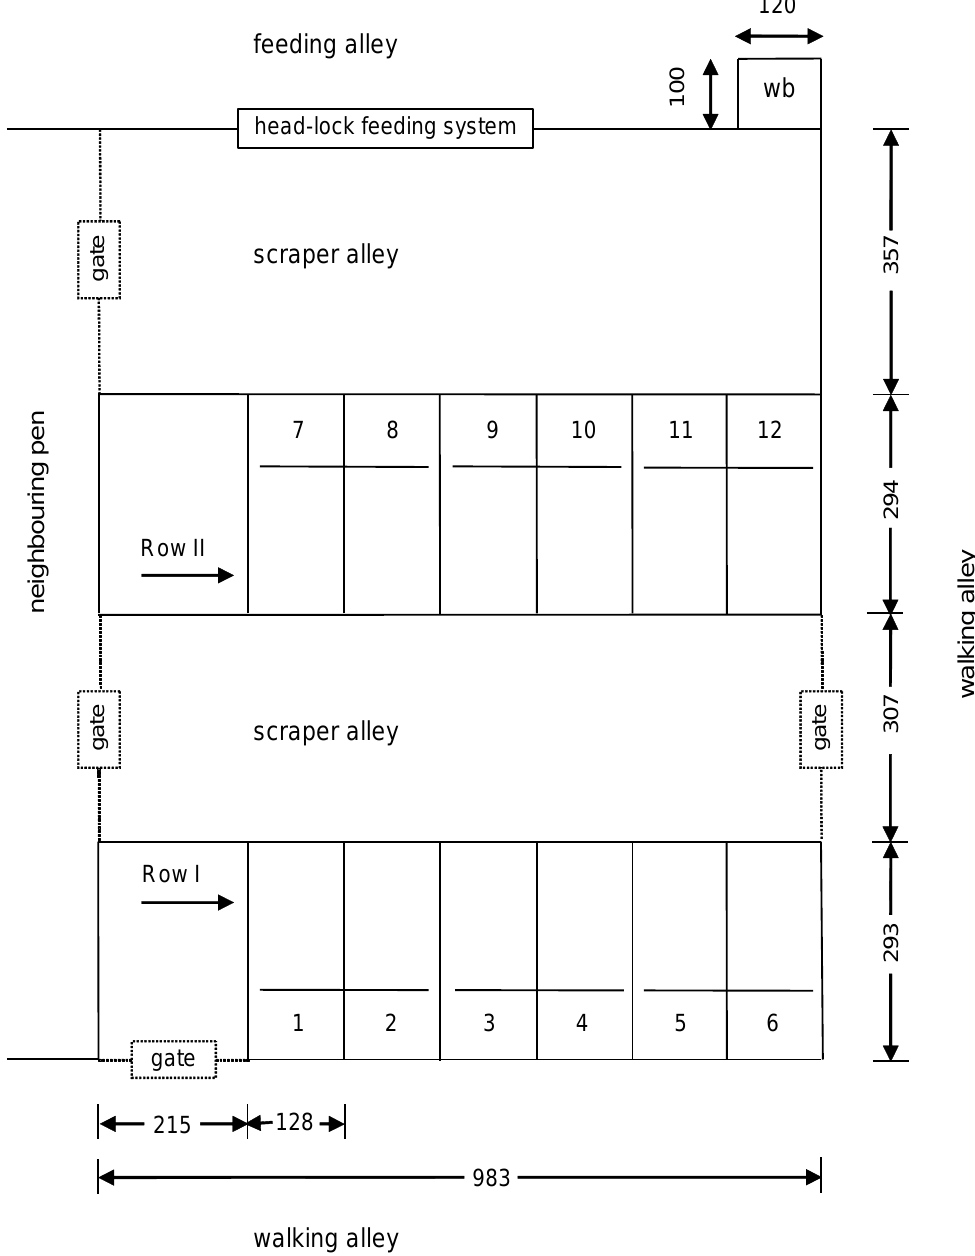
Figure 1. Configuration of the pen used for the experiment with modified neck rail taking into account row numbers (I and II), stall numbers (1 – 12), outside details, and dimensions (cm); wb, water bin.